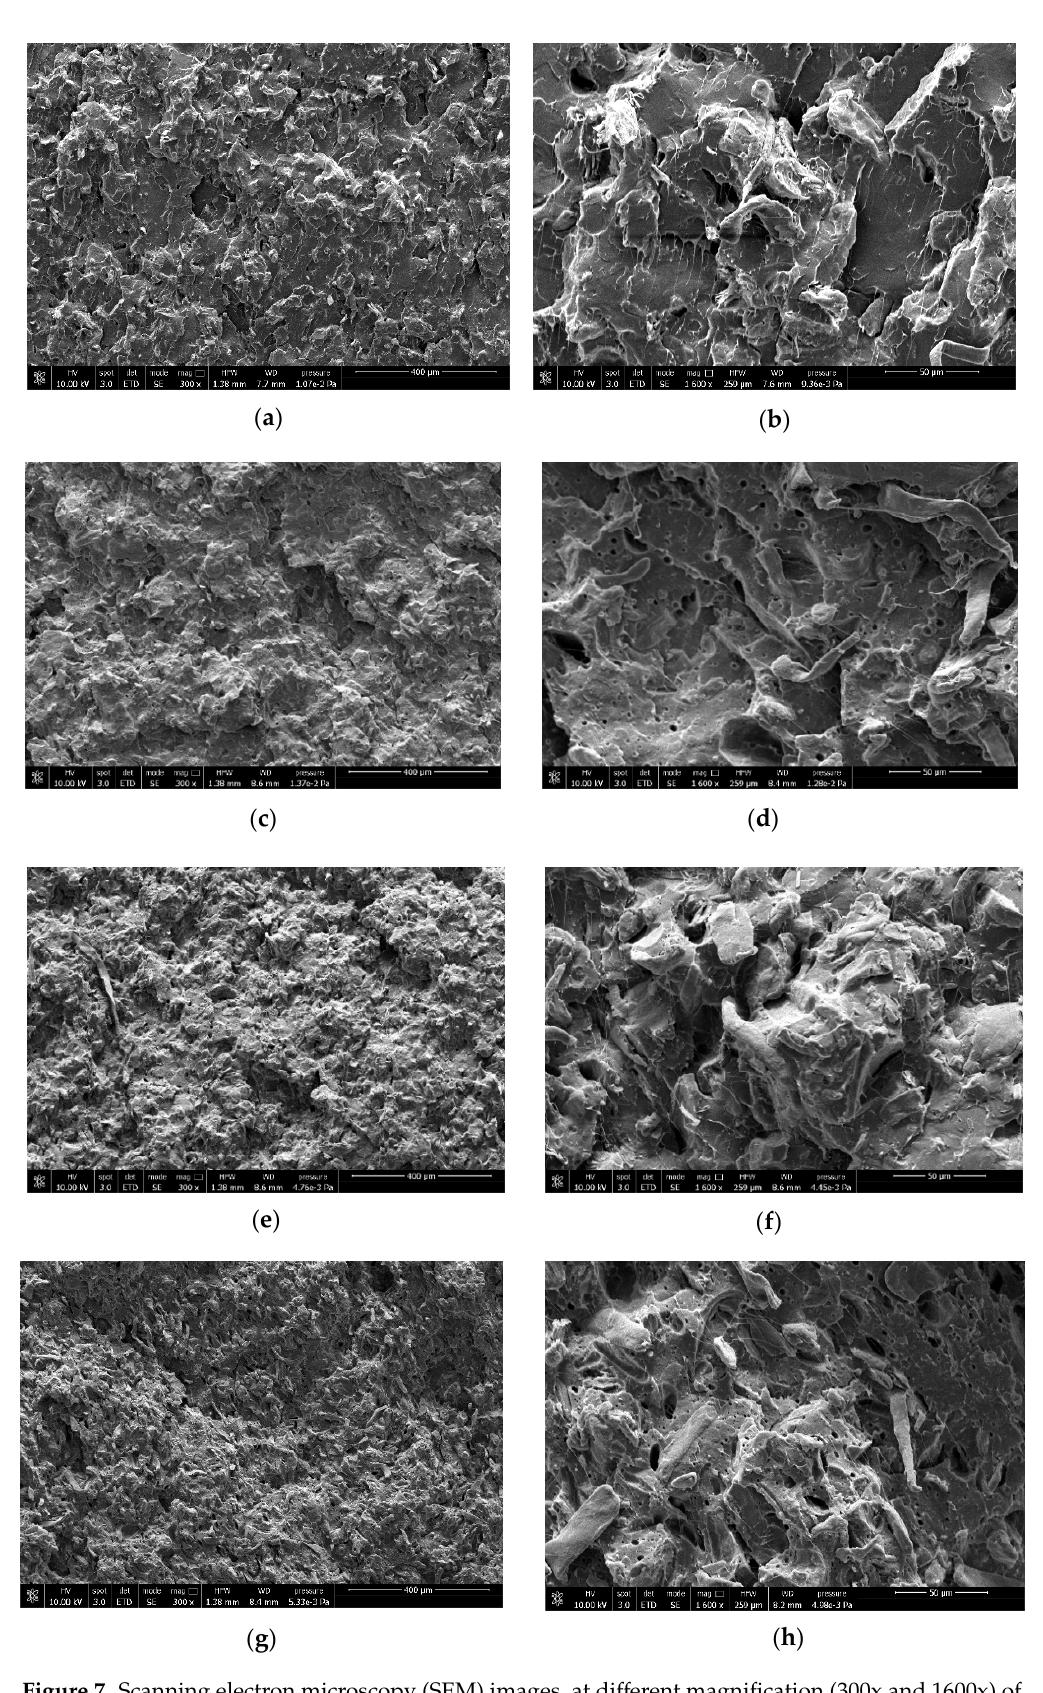
Figure 7. Scanning electron microscopy (SEM) images, at different magnification (300x and 1600x) of some of the composites investigated: ( a,b ) PLA_10, ( c,d ) PLA_10_E, ( e,f ) PLA_25, ( g,h ) PLA_25_E.